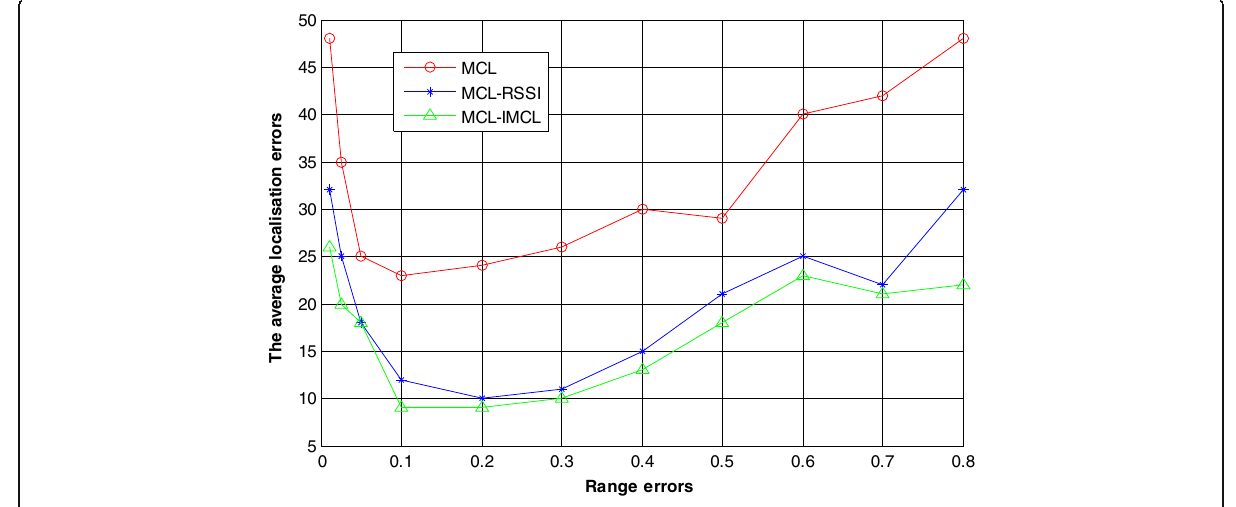
Fig. 4 Comparison of localization errors over different range